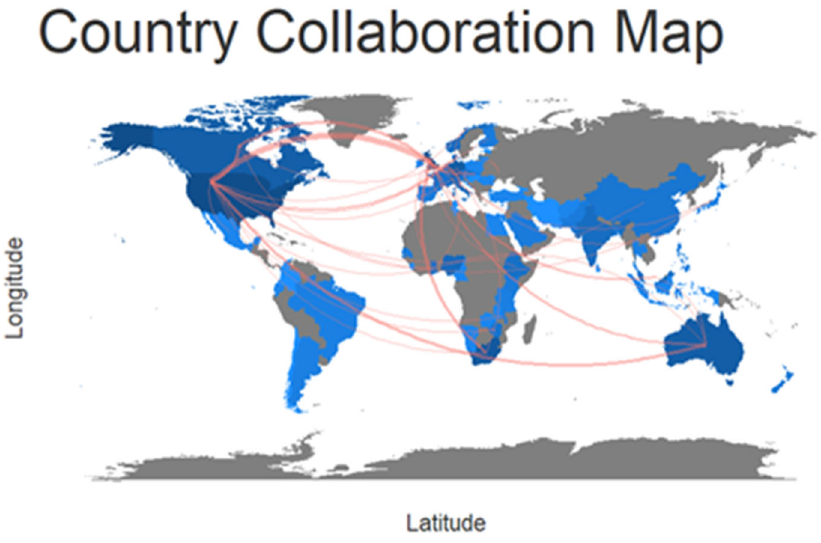
Figure 4. Country collaboration map. Source: Scopus/Biblioshiny.